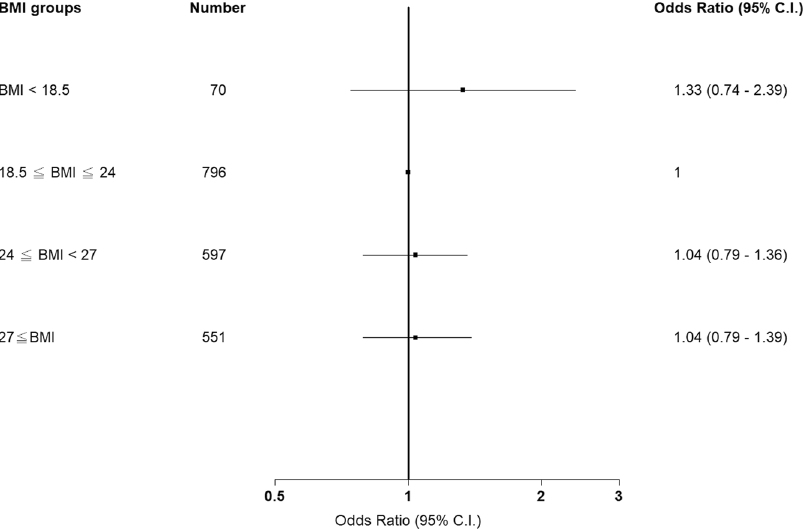
Figure 4. Association between body mass index and the risk of estimated glomerular filtration rate progression among patients with chronic kidney disease stages